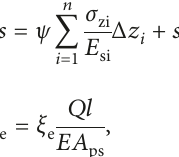
Figure 5: Settlement of TS1 pile and TS2 pile under each loading